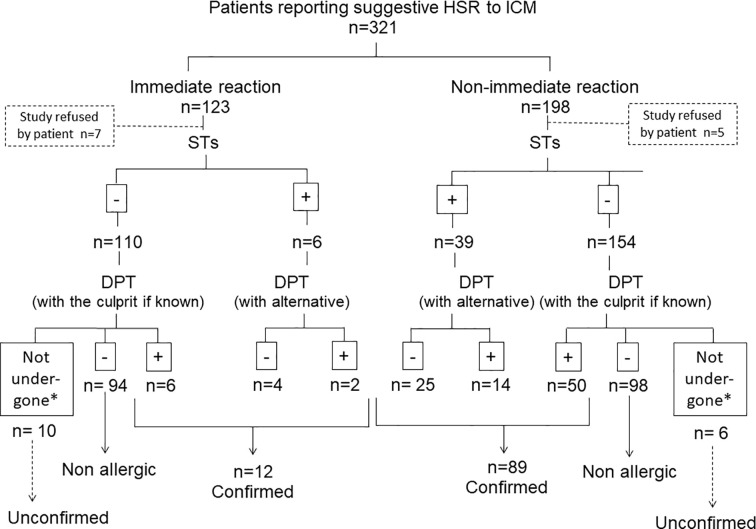
Flow-chart for the patients included in the study. *Due to contraindications for DPT: 15 cases due to comorbidities and 1 case due to the severity of the reported reaction (Stevens-Johnson syndrome).